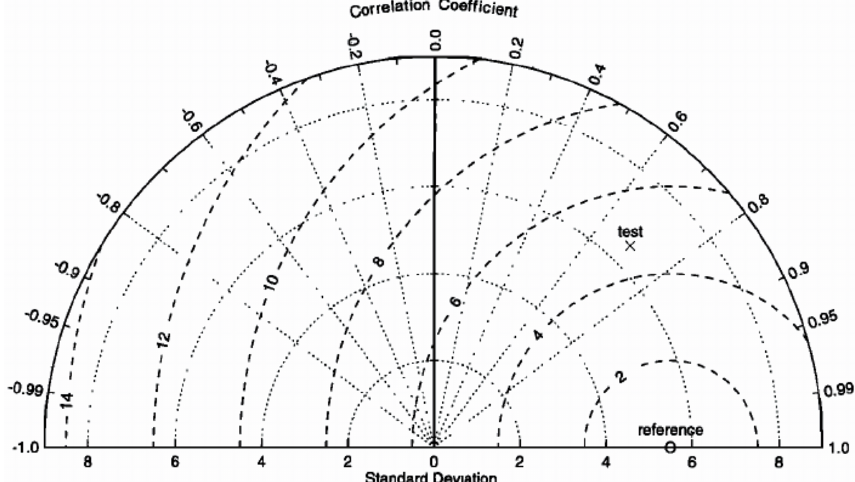
Figure 4. Taylor diagram from Taylor (2001). The standard deviation of model fields is displayed as the radial distance from the origin and can be visually compared to the observed (reference) point, which is indicated by a circle on the abscissa. The correlation between the model and observed fields decreases with azimuthal angle (dotted lines), and the root-mean-square difference between the model and observed fields is proportional to the distance from the reference point (quantified by dashed